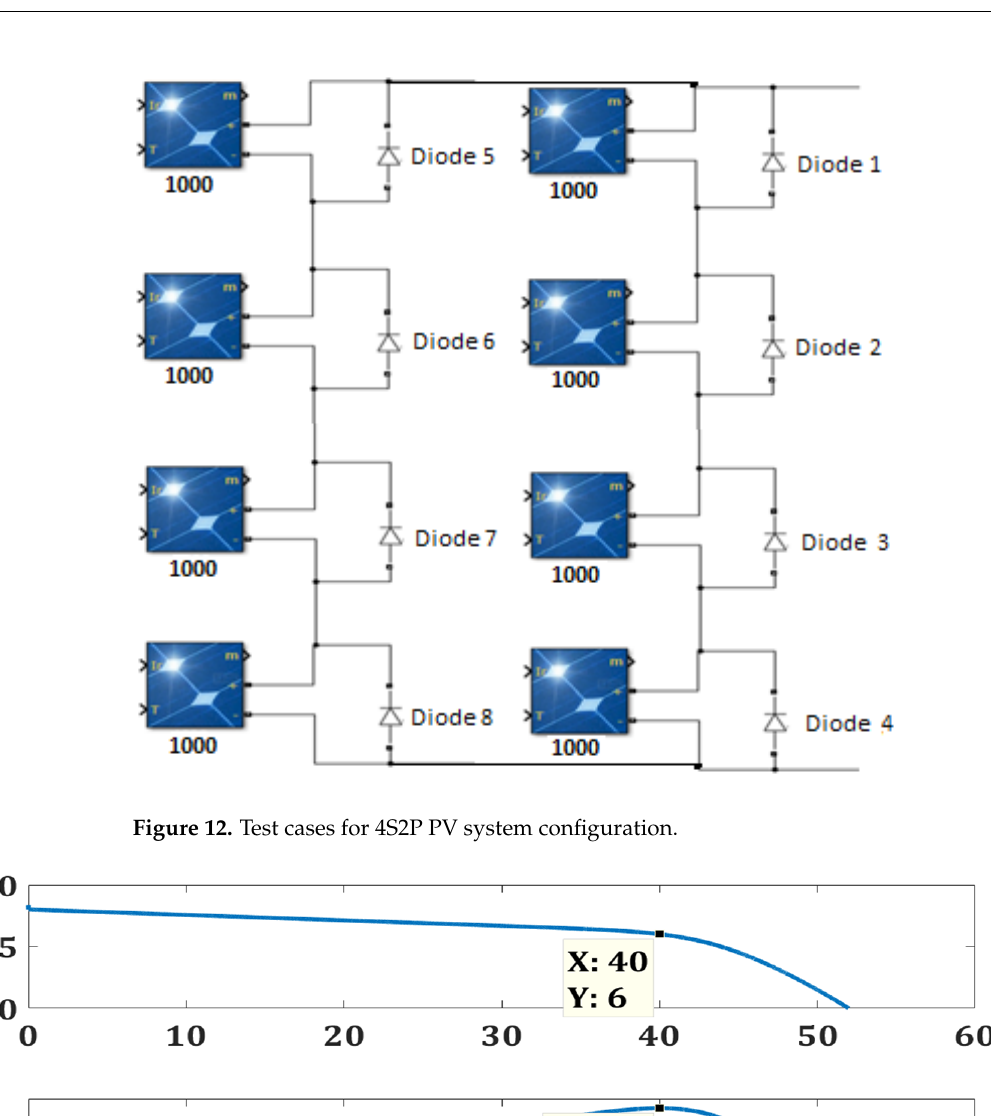
12 of 31 Figure 11. Authentication of OTCA under continuously changing weather conditions. Table 6. Summary of results for the proposed OTCA MPPT algorithm. Shading Patterns